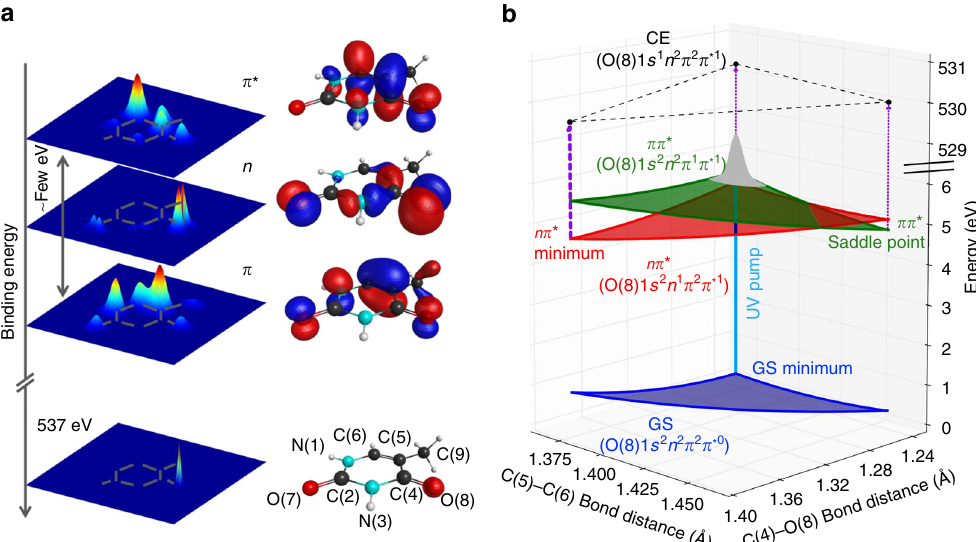
Fig. 1 Excited states of thymine and their electronic characters. a Isosurface representations ( right ) and electron density projections onto the molecular plane for the three valence orbitals (Hartree – Fock/6-311G) involved in the characters of the two lowest lying excited states of thymine and a core orbital localized at oxygen(8). The electron density at the position of the core orbital differs strongly for the different valence orbitals. b Results from our coupled cluster investigation of the excited-state topology along the two most relevant degrees of freedom for relaxation into the n π * minimum. All states are labeled with their electron con fi guration. Ultraviolet (UV) excitation of the ground state (GS) places a nuclear wavepacket ( gray ) on the ππ * excited state. It relaxes through a conical intersection to a minimum in the n π * excited state. According to our calculations, only one core-excited state (CE) characterized by an excitation at O(8) is relevant for interpretation of our experimental